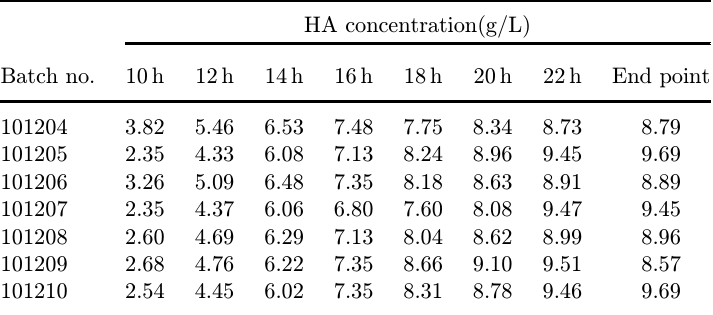
Table 1. HA concentrations in fermentation broth at di®erent times.